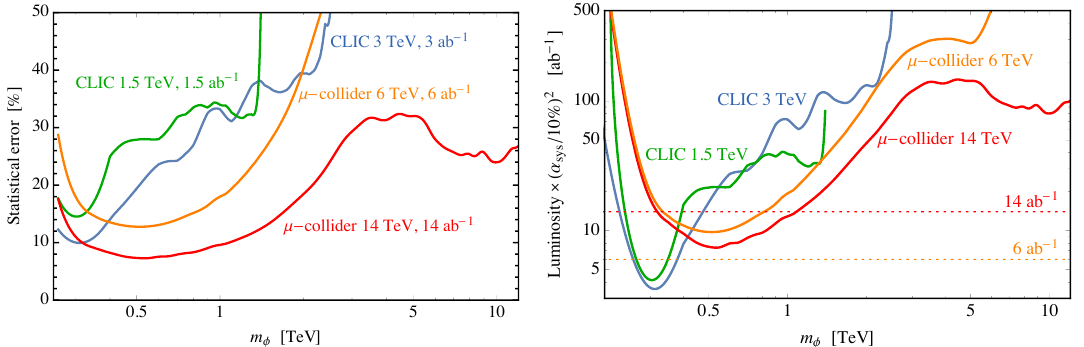
Figure 16. Left: statistical uncertainty on the background expected in resonant hh searches at CLIC and muon colliders. Right: luminosity at which the impact of statistical uncertainties on our sensitivities becomes equal to the one due to systematics (above the continuous lines a systematic uncertainty of 10% is more important than the statistical